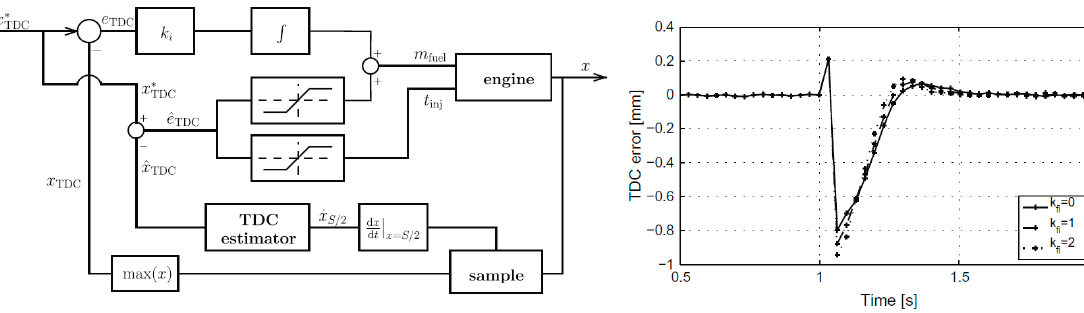
Figure 32. Newcastle University’s point-of-position control strategy and bottom-to-point control error [81].